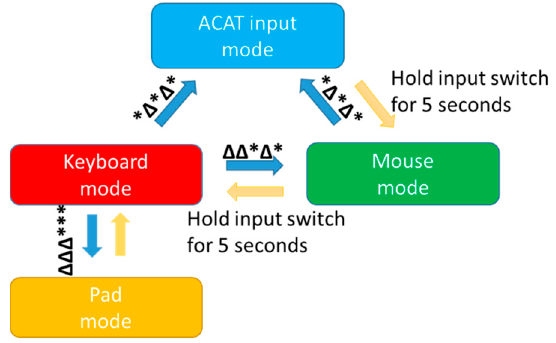
Figure A1. Function modes exchange of Morse code translator (MCT). (*: short tone, ∆ : long